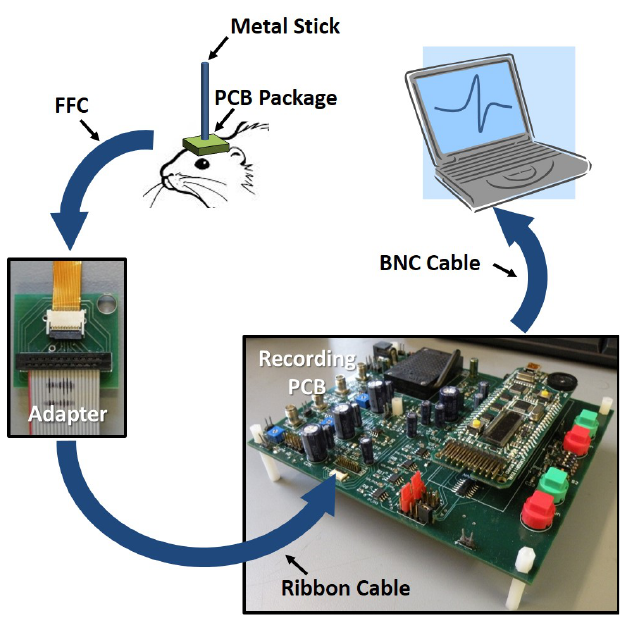
Figure 13. Illustration of the rat cortical recording